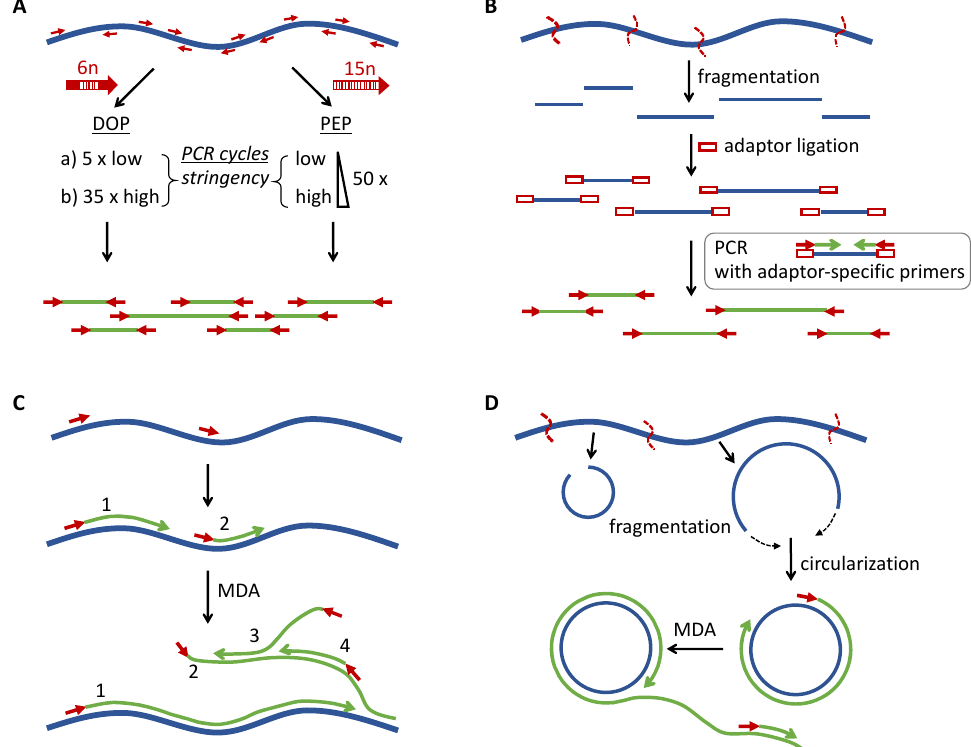
Figure 2. The most commonly applied WGA principles. ( A ) PCR using primers (red arrows) with randomized sequences. DOP-PCR uses primers in which 6 random nucleotides (6n; open rectangles) are flanked by fixed sequences (filled parts of the arrow), and the PCR program consists of a few low-stringency cycles, followed by high stringency cycles that specifically amplify the products of the low stringency step. PEP PCR uses completely randomized primers (15-mers, 15n), and the annealing temperature is continuously raised in each PCR cycle. ( B ) Adaptor ligation-PCR. The template DNA is fragmented, and after ligation of adaptor oligonucleotides to both sides, the fragments are amplified using adaptor-specific primers (red arrows). ( C ) Isothermal amplification by MDA. After denaturation, random hexamer primers anneal to the template DNA and are elongated using phi29 polymerase. Preceding double strands will be displaced by phi29, generating novel single-stranded templates for further primer annealing and extension. By this means, DNA can be amplified at a constant temperature of 30 ◦ C. The numbers refer to the order of strand displacements. ( D )